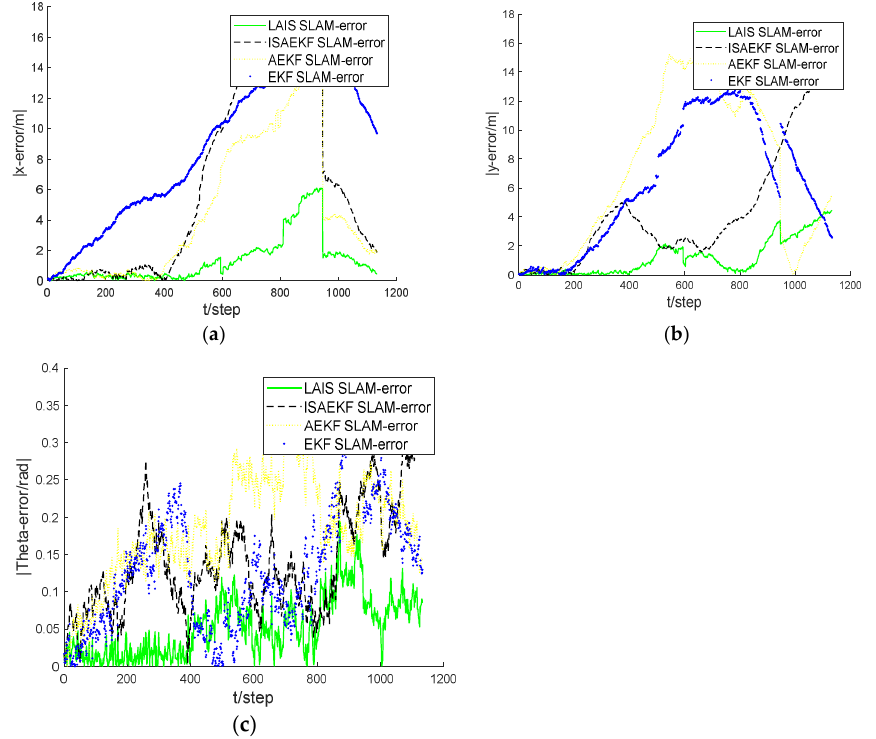
Figure 5. Error of each algorithm when the signpost point is 60 under achromatic noise. ( a ) x axis direction error. ( b ) y axis direction error. ( c ) Rotation angle error.